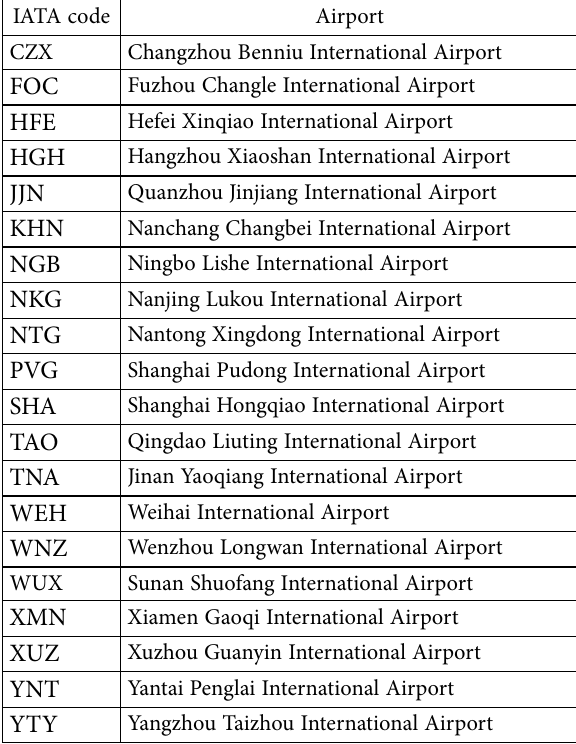
Table A. Airports selected as DMUs IATA